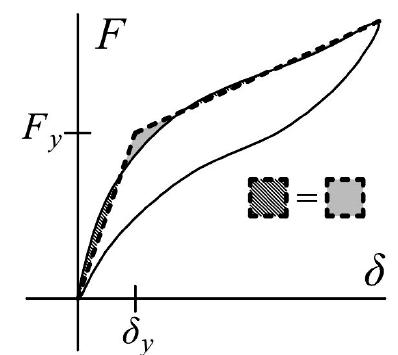
Figure 12. Idealization of the loading branch of the force-deformation curve with two segments.